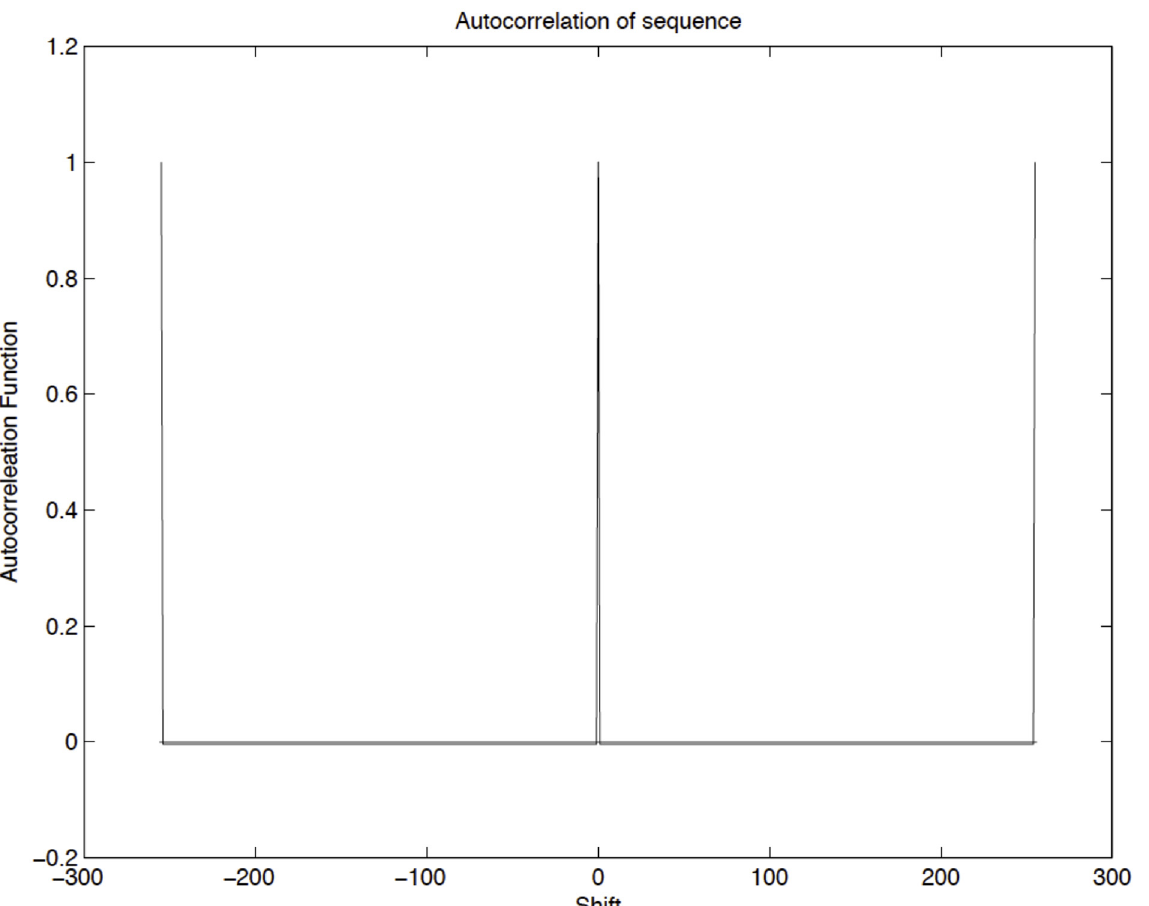
Fig 4. Autocorrelation function. Autocorrelation function of the pseudo-random number generator used in the experiments.